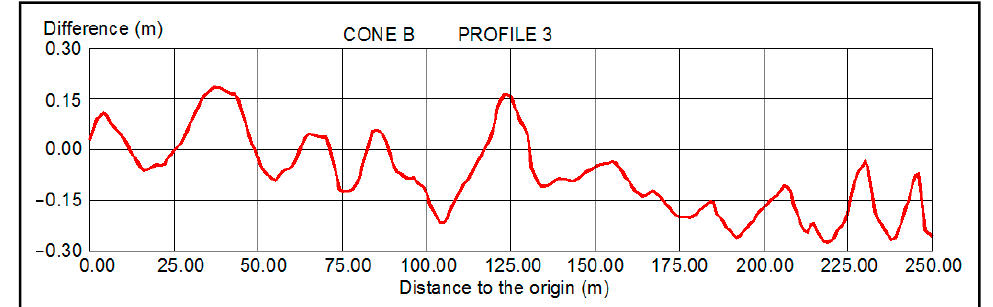
Figure 11. Predictive representation (in red) of profile 3 of Cone B. The rest of the curves belong to